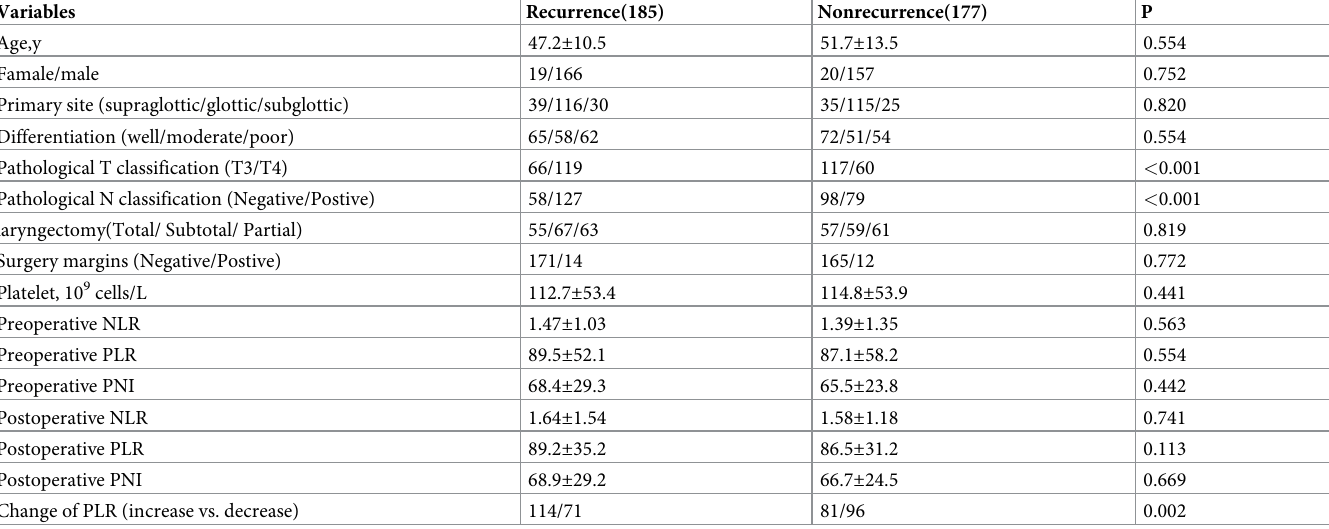
Table 2. Factors associated with postoperative recurrence in the univariate